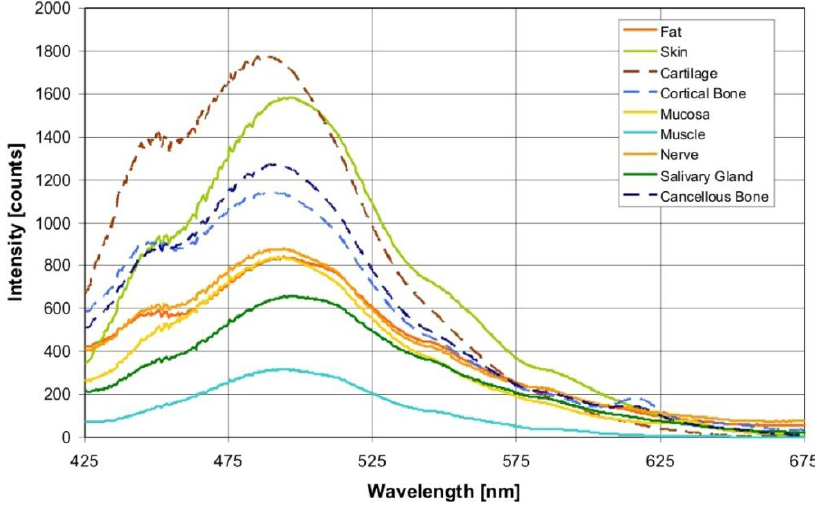
Figure 2. Autofluorescence spectra (averaged over 900 measurements per tissue type), excitation wavelength: 377 ± 50 nm).